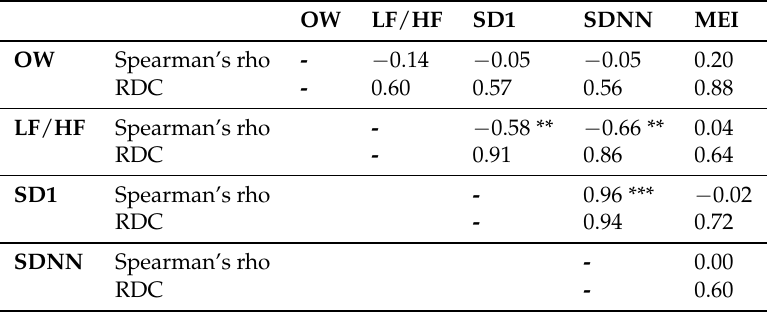
Table 4. Correlation Matrix for LA